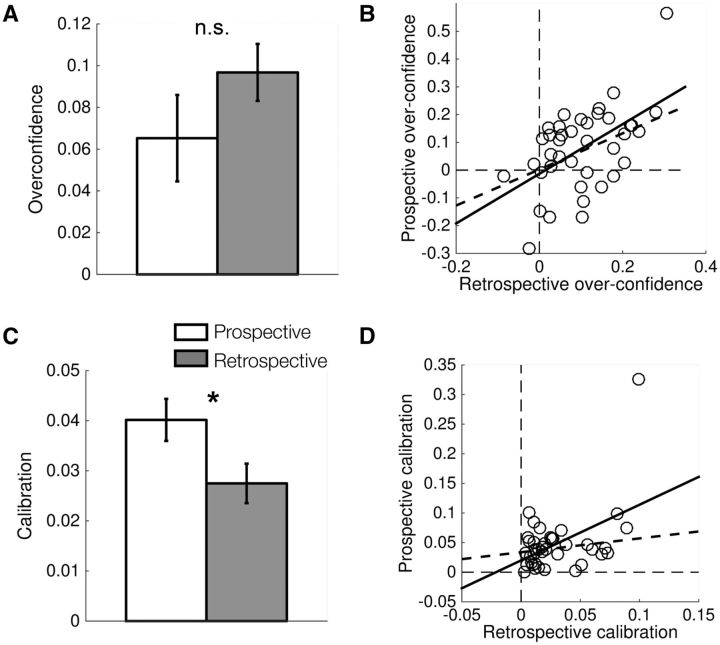
Comparison of confidence levels for prospective and retrospective confidence
judgments. (A) Global overconfidence (mean confidence – mean
performance) for prospective and retrospective judgments (B)
Relationship between prospective and retrospective overconfidence across subjects.
(C and D) As for (A and B), but for calibration, where a
lower calibration score indicates that confidence levels are closer to objective
performance. The dotted regression lines in (B) and (D) are computed after omitting
the outlying data point. *P  <  0.05; n.s., not significant.